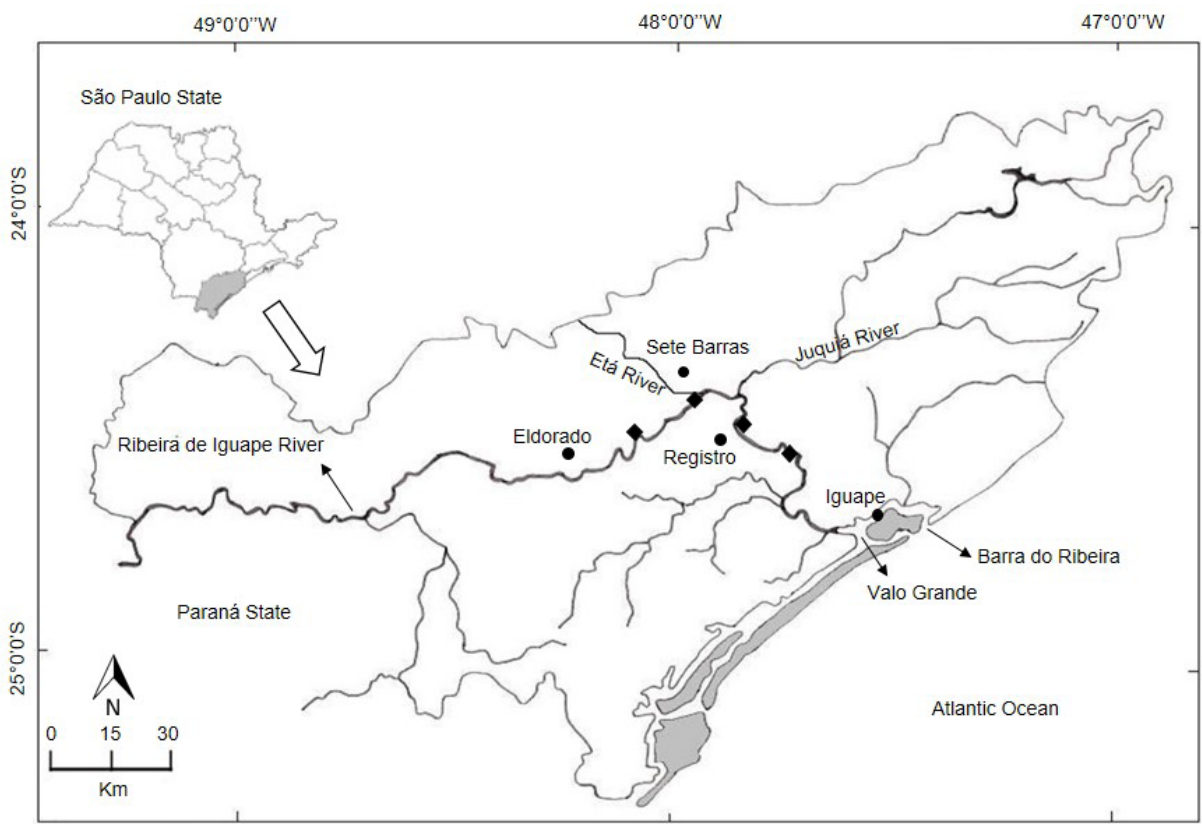
Figure 1. Map of the Ribeira de Iguape river basin, São Paulo, Brazil, showing the sampling sites (Eldorado, Sete Barras, Registro, and Iguape).